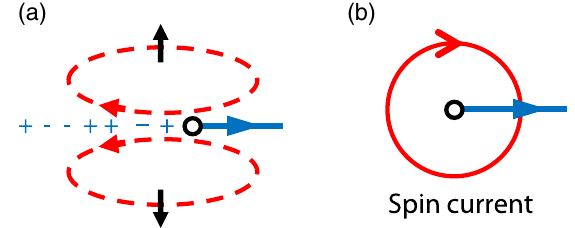
FIG. 1. The composite structure of a renormalized single-hole state discussed in Ref. [36]: (a) The motion (blue arrow) of a doped hole (black circle) creates a sequence of (cid:2) signs (phase string) depending on ↑ and ↓ of the backflow spins. To avoid cancellation of the phase-string effect in the hopping integral, the spin backflow currents have to bend into a rotonlike pattern (red dashed line) around the hole; (b) such a roton configuration can be explicitly manifested by a vortex of spin current around the 1 = 2 . The chirality of the hole as a net effect for an extra S z ¼ (cid:2) vortex leads to a double degeneracy of the states with an emergent 1 angular momentum L z ¼ (cid:2)